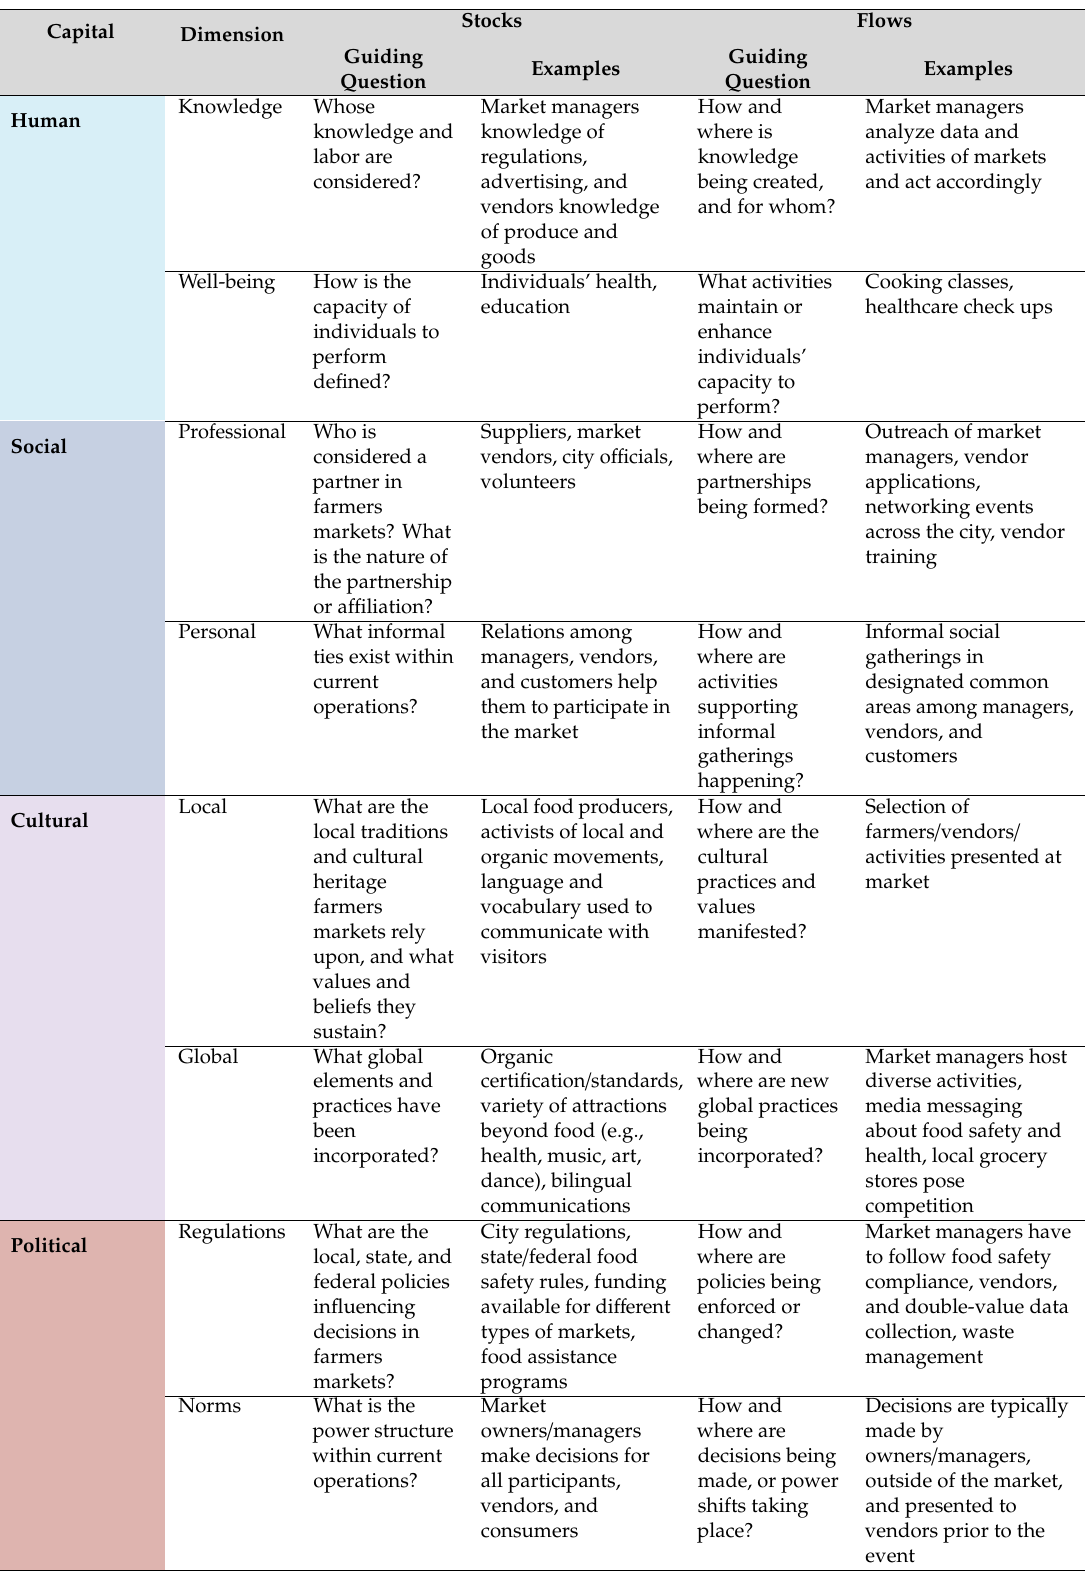
Table 2. Infrastructures, stocks, and flows of resources in farmers markets across Chicago.